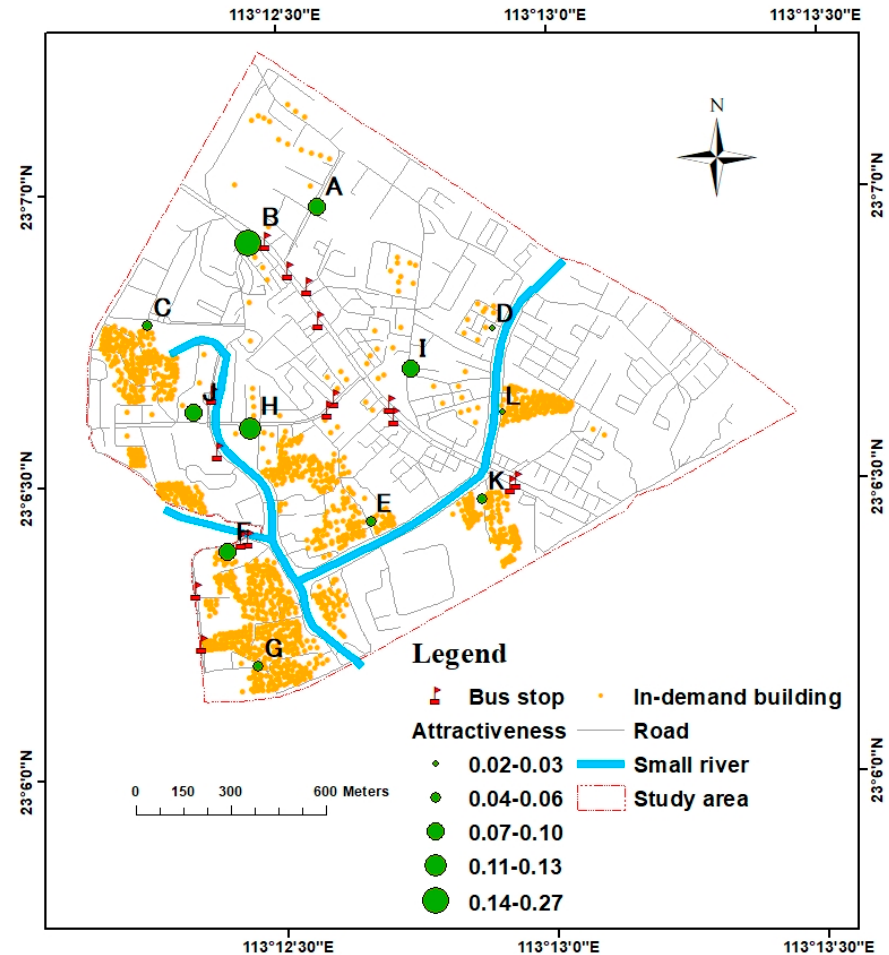
Figure 8. Attractiveness value of the facilitie s.